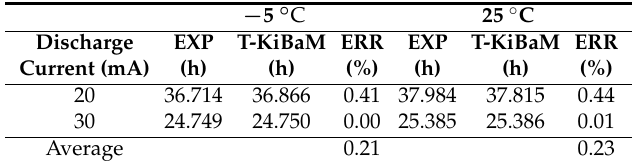
Table 7. T-KiBaM analytical results. EXP: Experimental result; ERR: Relative error. − 5 ◦ C